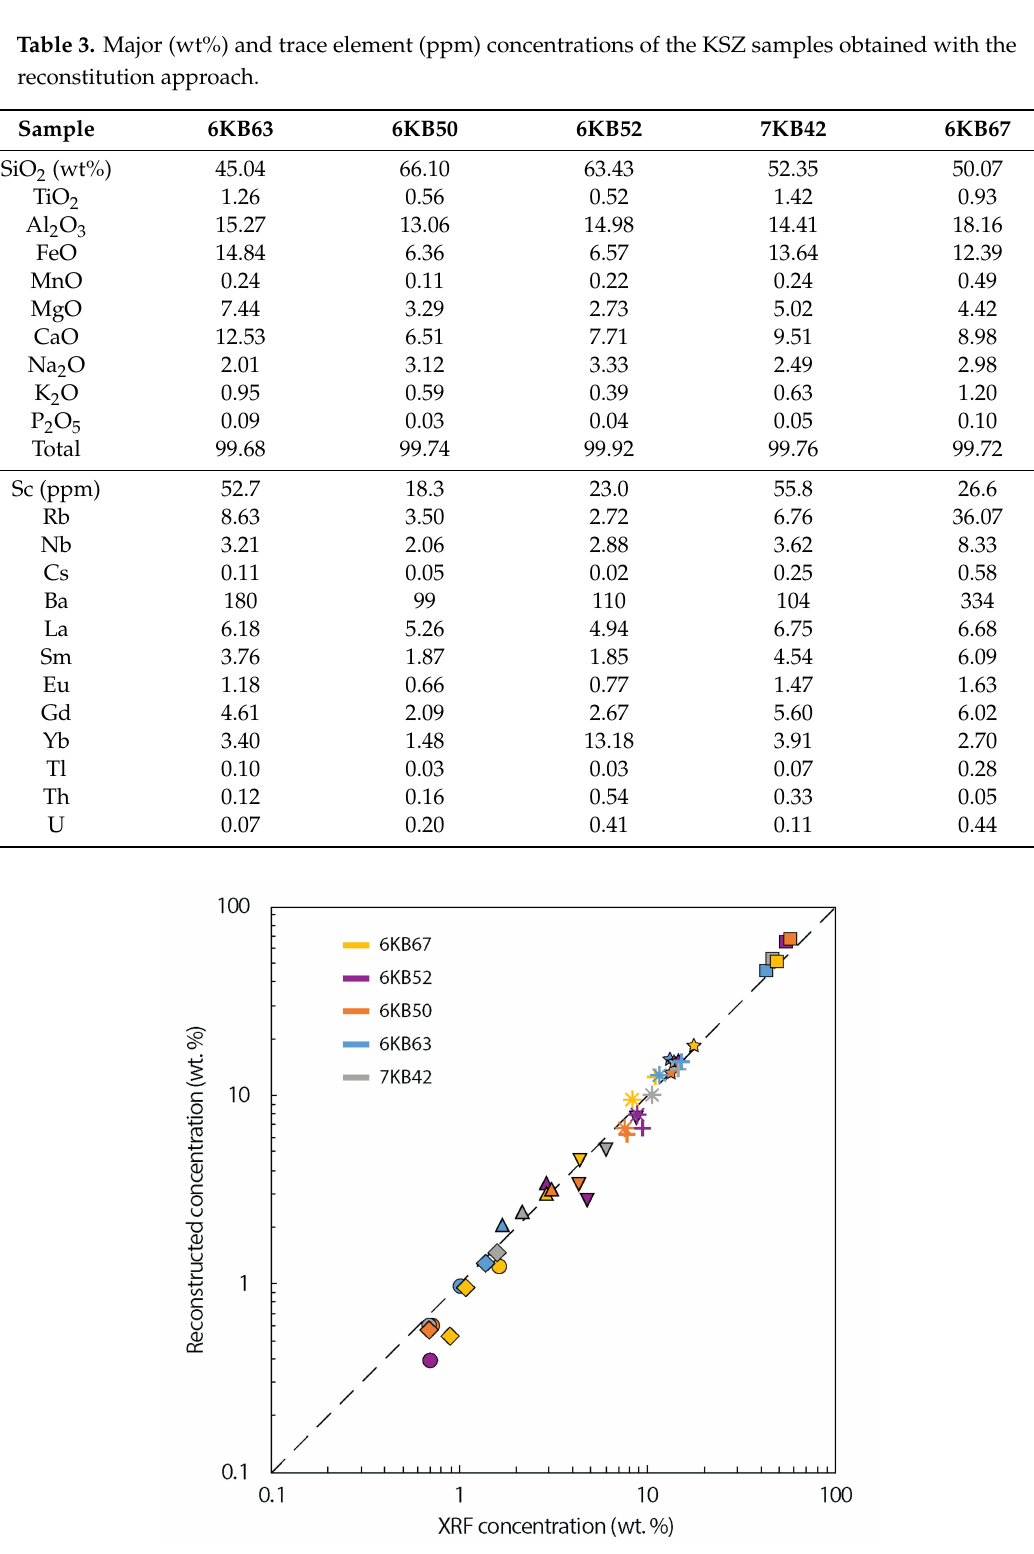
Figure 3. Comparison of major element concentrations of the five KSZ samples obtained by bulk rock X-ray fluorescence (XRF) and by the reconstruction approach. Symbols refer to di ff erent oxides: circles = K 2 O, diamonds = TiO 2 , triangles = Na 2 O, inverted triangles = MgO, asterisks = CaO, plus = FeO, stars = Al 2 O 3 , squares = SiO 2 . The dashed black line shows the theoretical 1:1